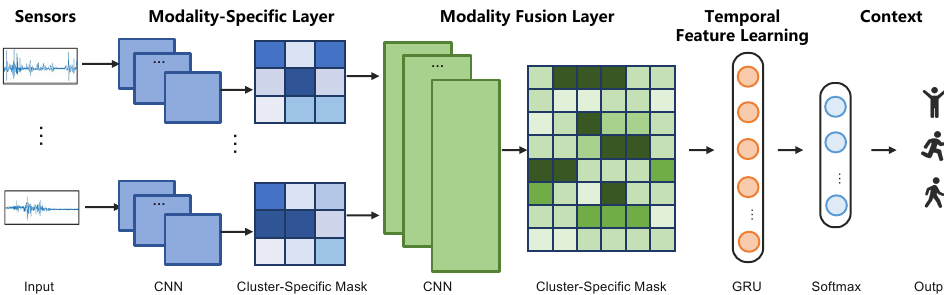
Figure 3. The architecture of the attention-based meta-learning model for diversity-aware activity recognition. The CNNs in the modality-specific layer and modality fusion layer are transferred from the central model and trained locally with the rest components on the client side. The detailed structure of the attention-based, cluster-specific mask operation is introduced in the next